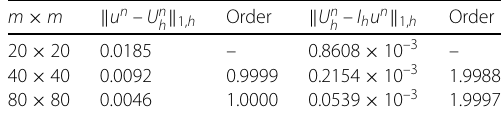
Table 4 Numerical results at t = 1.0 with τ = 5 h